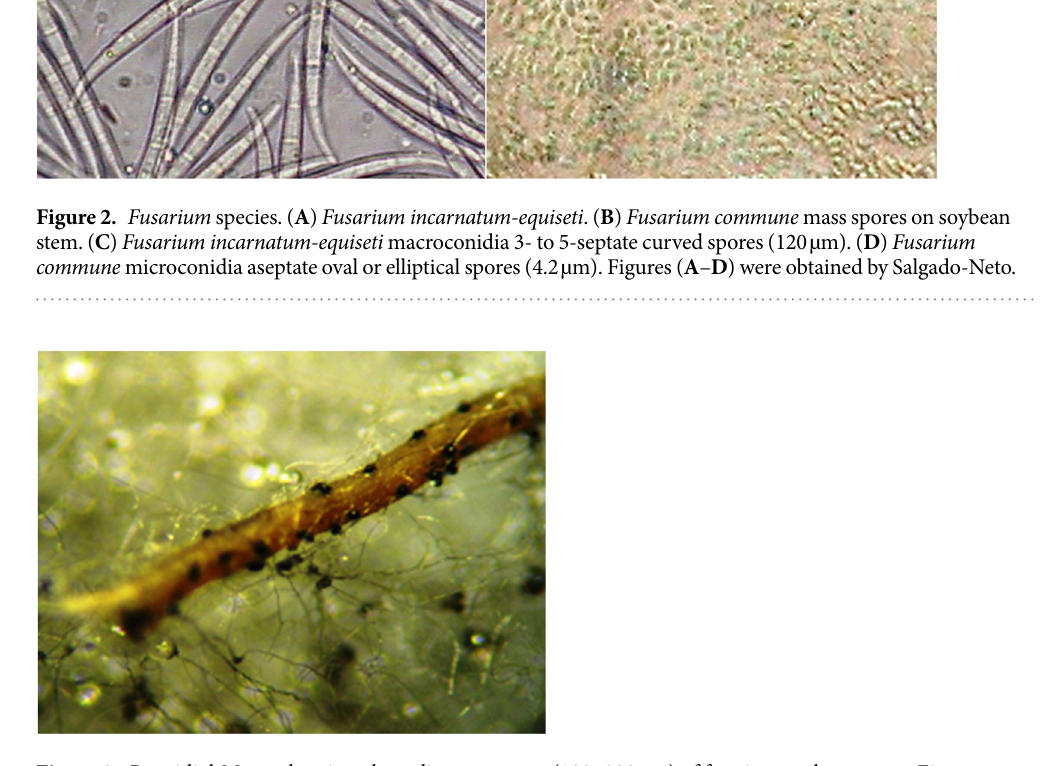
Musca domestica L. (Muscidae: Diptera) did not alter the spores in their physical appearance or ability to germi- nate 29 . One potential biochemical capability detected in Fusarium isolates that may benefit insect hosts include sterol synthesis, detoxification of (plant or venomous preys) derived allelochemicals and secondary metabolites, and nitrogen scavenging from unconventional substrates, including cyanide and formamide 30 . The presence of Fusarium species in the midgut suggests that C. sanguinea may be harboring this fungus in order to benefit from its metabolic capabilities. Coccinellids are mycophagous, foraging in patches of asexual spores, may acquire conidial inoculum acting as mechanical vectors of pathogens 31,32 . The fungal spores are attractive as food for coccinellids, and therefore should not survive digestion. However, spores remained viable in the mycophagy Halyziini-powdery mildew system 31,32 . Another system involves a diet of aphids present on apple for the coccinellid Hippodamia convergens Guérin-Méneville carrying the fungal pathogen Discula destructiva Redlin (dogwood anthracnose) excreting via- ble spores 31–33 . In this context, spores Fusarium are found in plant tissues where phytophagous insects can acquire them via the cuticle or midgut, and, consequently, these spores are acquired by C. sanguinea through predation.